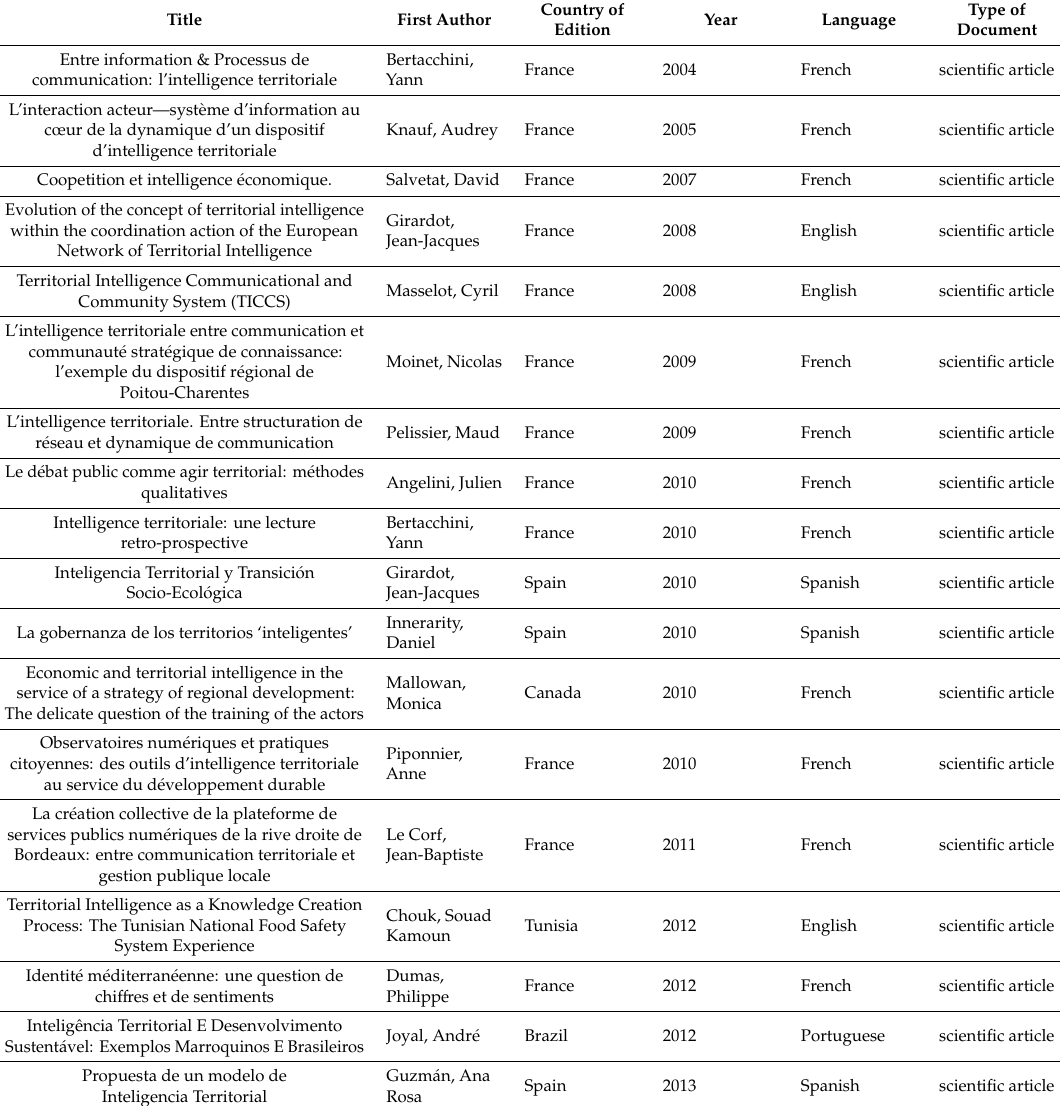
Table 3. Charting table . Documents included in qualitative